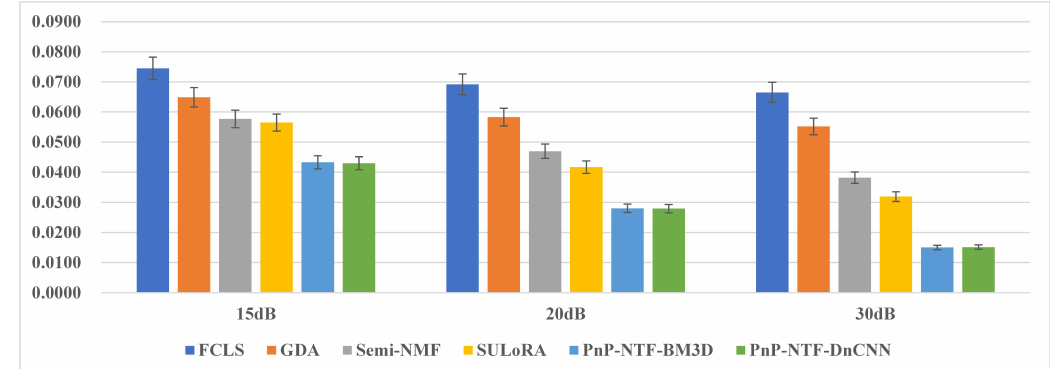
Figure 5. Evaluation results of RMSE with the proposed method and state-of-the-art methods on ‘Scene2’.